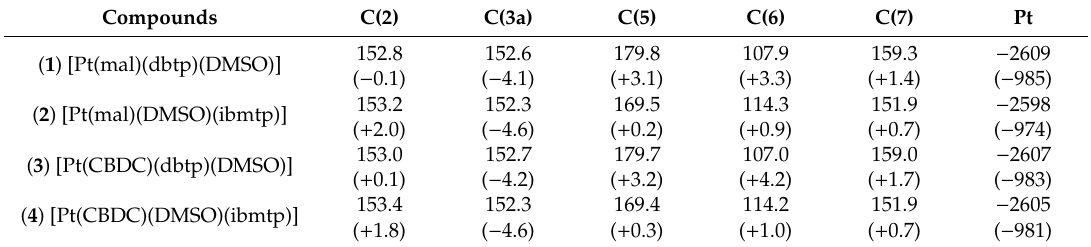
Table 3. 13 C and 195 Pt NMR chemical shifts ( δ ) of platinum(II) complexes [in ppm].